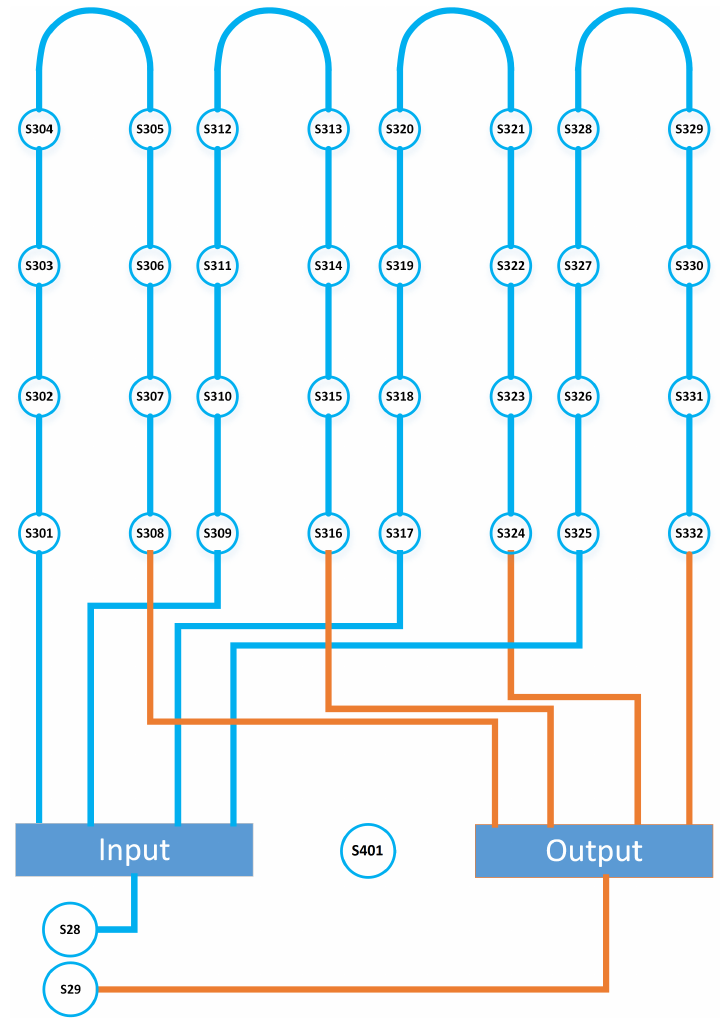
Figure 2. Geothermal exchanger sensors